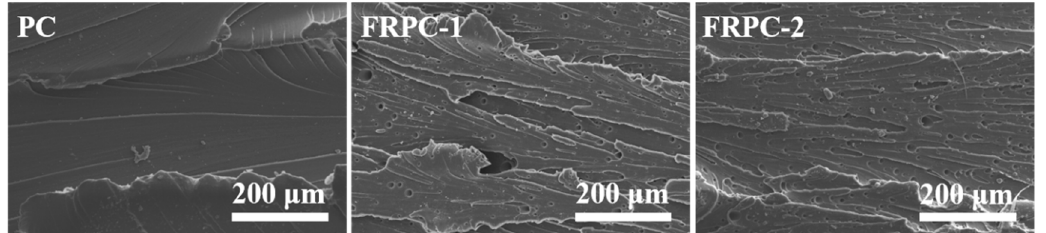
Figure 7. SEM images of the impact-fractured surface of PC and its FRPCs.